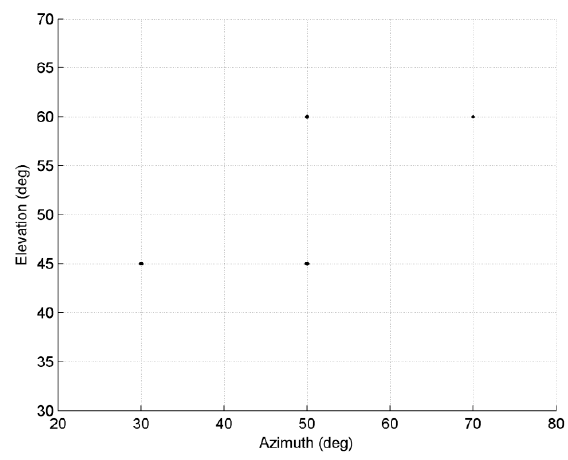
Figure 3. ( a ) RMSE θ estimated with θ changing from 0° to 180° while φ is fixed at 20°; ( b ) RMSE φ estimated with φ changing from 0° to 180° while θ is fixed at 20°.